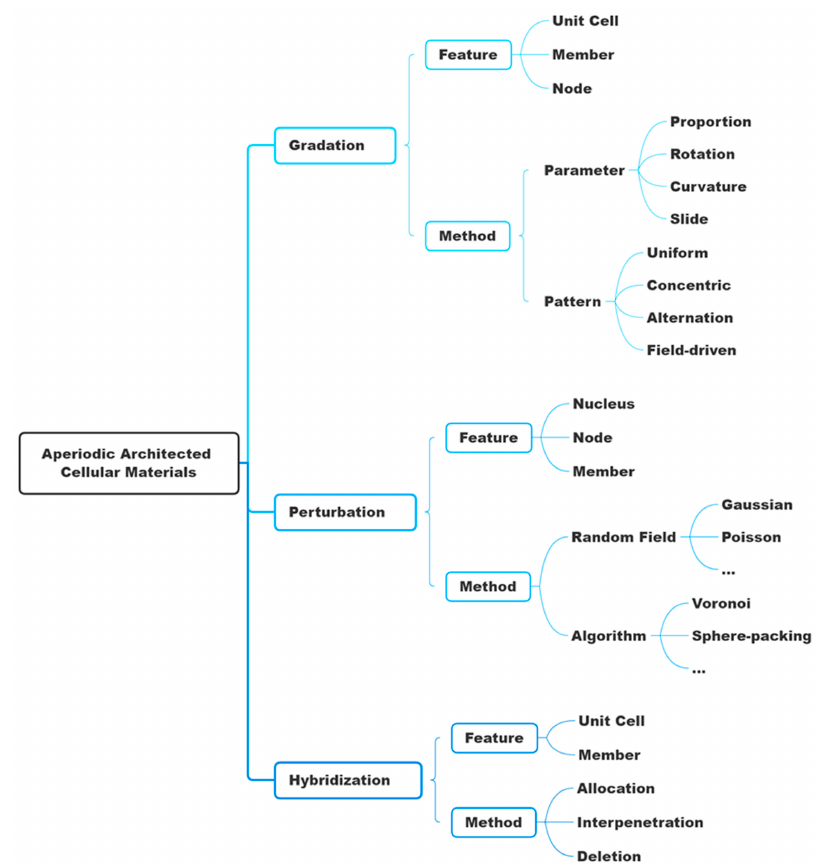
Figure A1. The complete classification proposed in this work.